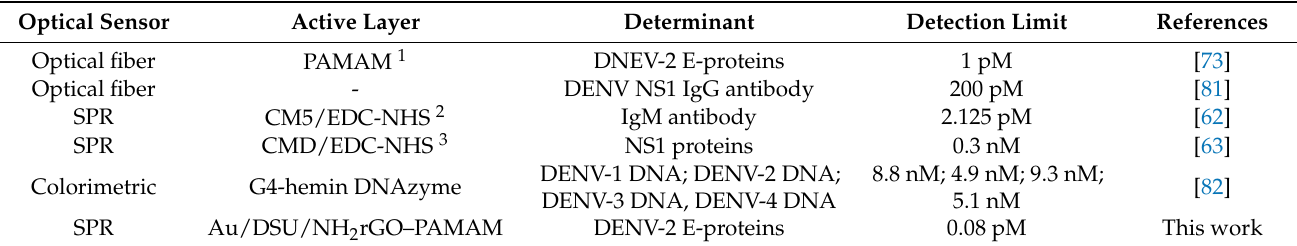
Figure 4. The reflectance curves of 0.000008–0.0001 nM of DENV-2 E-protein detection. Table 2. Recent studies and comparison of detection limit for DENV based on optical sensor.